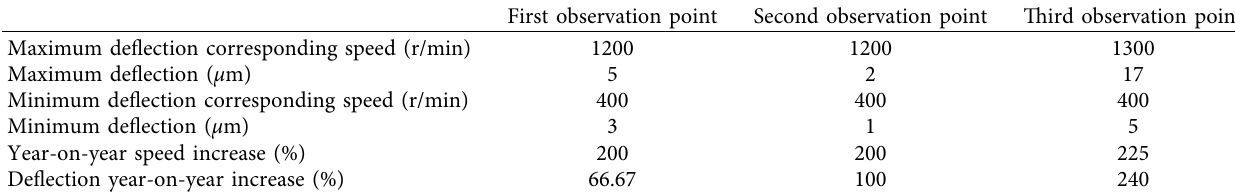
Table 15: Data summary of span-suspension ratio of 1:0.75.